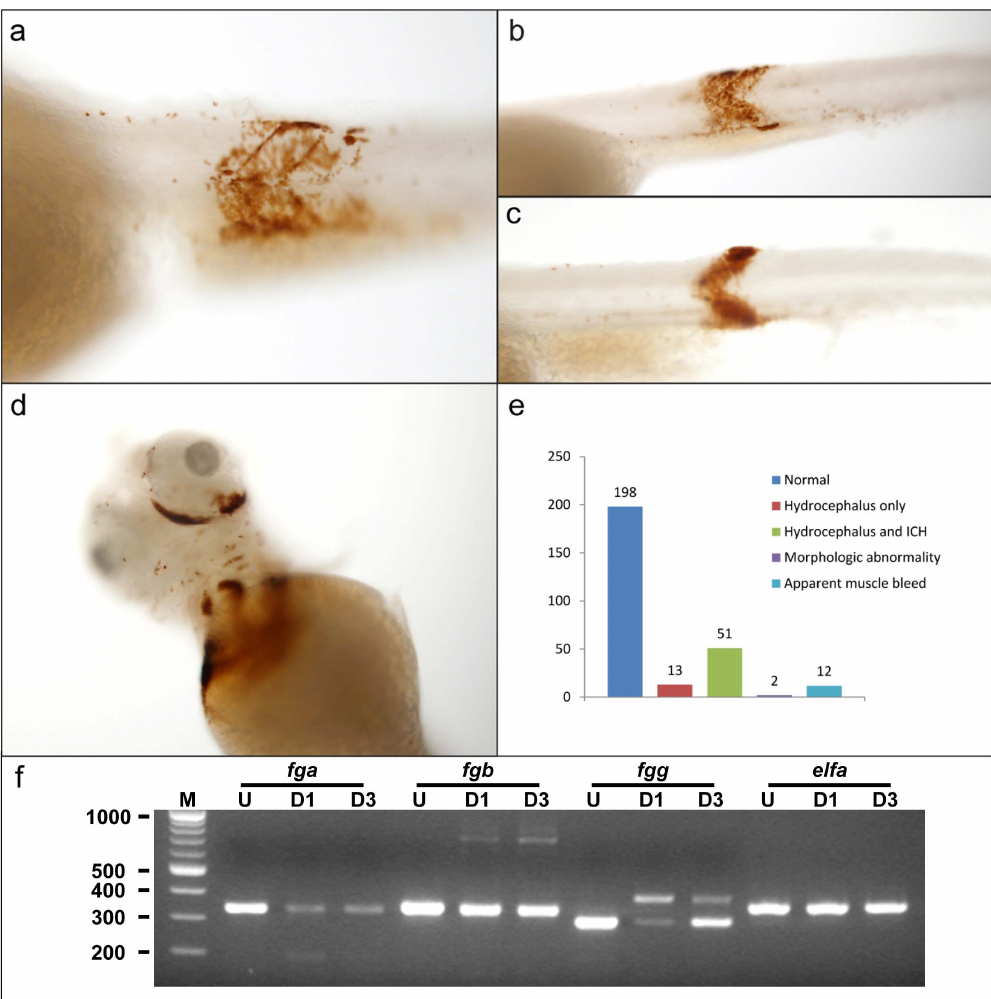
Figure 4. Additional sites of hemorrhage in fibrinogen morphants. Other sites of hemorrhage were visible in morpholino-injected larvae. Single cell embryos were injected with 1 nl of a mixture containing a final concentration of 0.5 mM of each of fga , fgb , and fgg splice blocking MOs, and then analyzed at 3 dpf by o-dianisidine staining. (a–c) Examples of morphants with intramuscular hemorrhage. Arrow shaped muscle segments are clearly highlighted by o-dianisidine staining, indicating hemorrhage. (d) Example of orbital hemorrhage. (e) Larvae were evaluated under a low power dissecting microscope and scored in the categories described. The 12 larvae with apparent muscle bleeds (as shown in a–c) also had hydrocephalus with or without ICH (intracranial hemorrhage). Control larvae displayed no abnormalities. (f) RT-PCR analysis of larvae after MO injection. Total mRNA was prepared from pools of 10 embryos or larvae that were uninjected (U), 1 day post injection (D1), or 3 days post injection (D3). RT-PCR was performed using primers in exons flanking the target splice donor sites. The quantity of parental cDNA product was diminished after injection, and altered splicing lead to additional products that were reduced ( fga ) or increased ( fgb and fgg ) in size, consistent with MO knockdown. elfa (elongation factor I alpha) was included as control for mRNA integrity. M, molecular weight marker with sizes in base